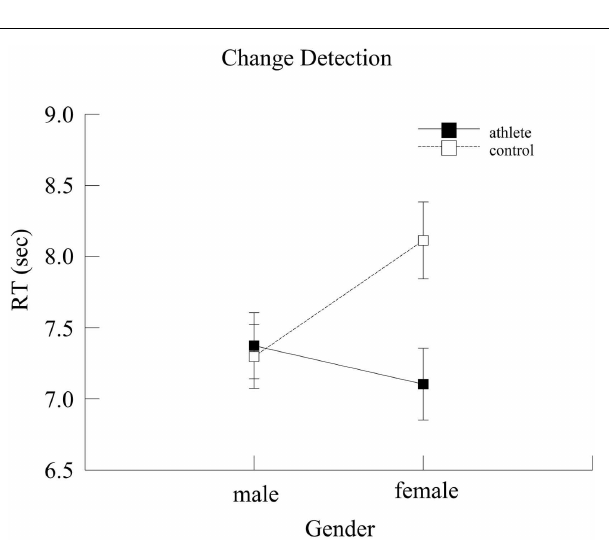
FIGURE 6 | Mean reaction time (s) for the two groups as a function of gender. Error bars represent ± 1 standard error.